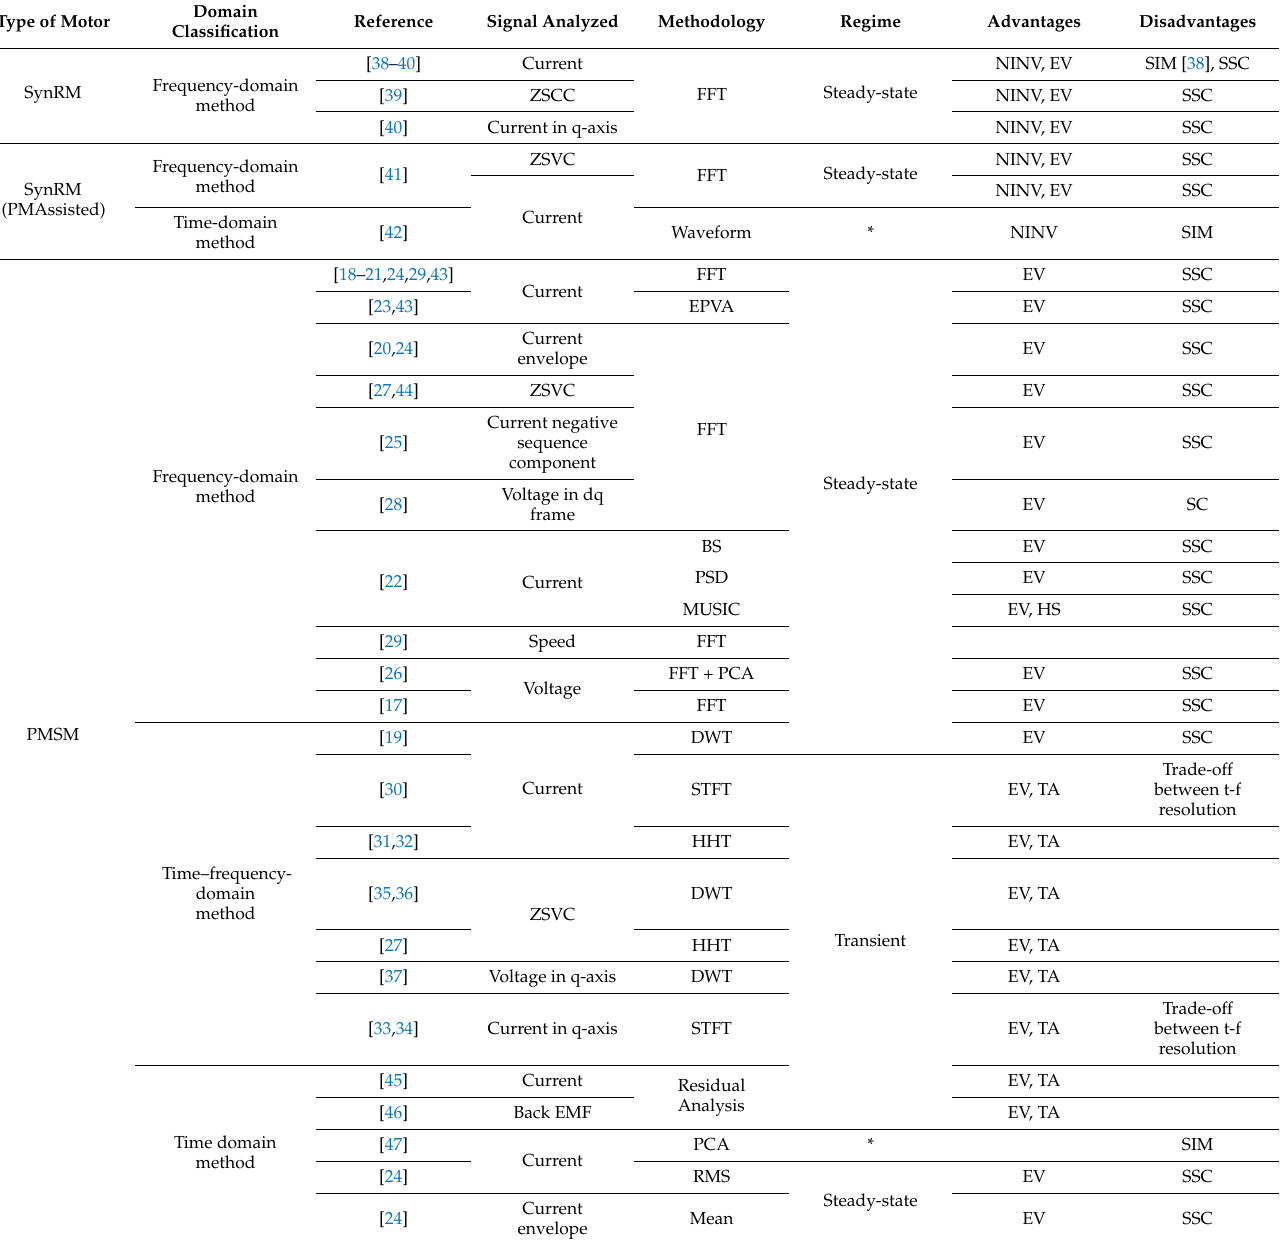
Table 1. Classification of detection methods for stator short-circuit faults in PMSMs and